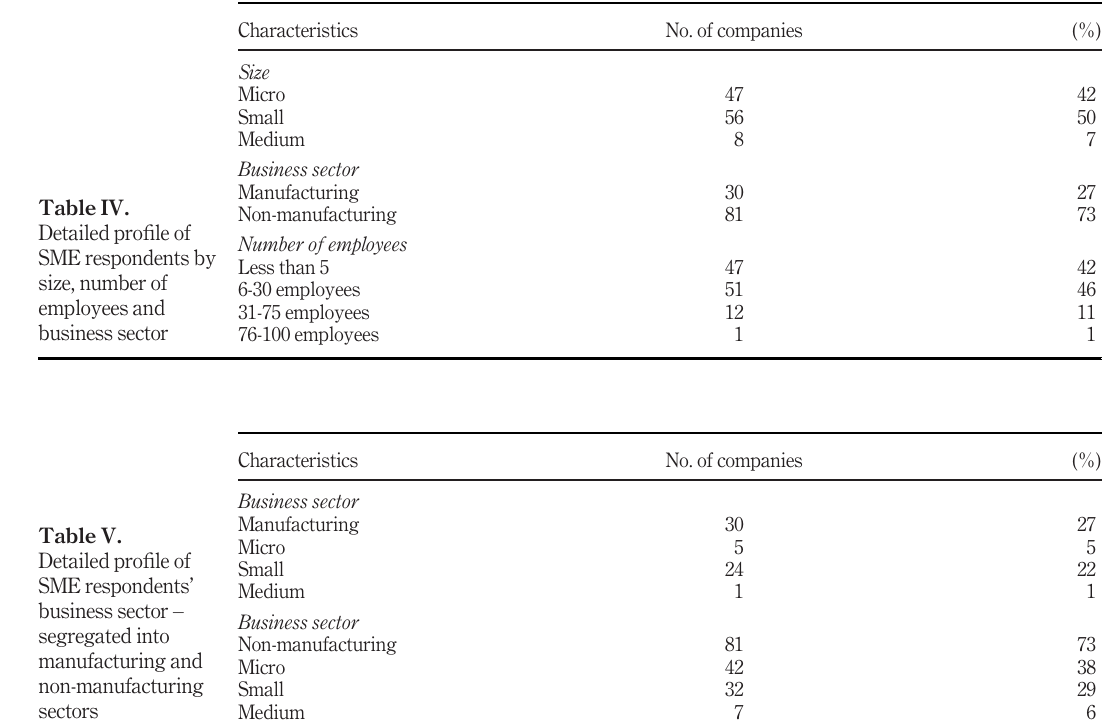
Table V. Detailed pro fi le of SME respondents ’ business sector – segregated into manufacturing and non-manufacturing sectors